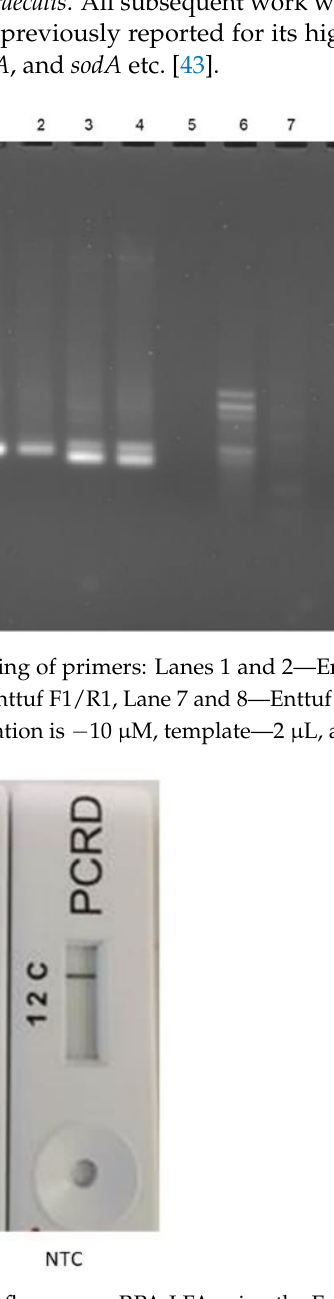
Figure 2. Lateral flow assay: RPA-LFA using the Ent rpoB F1/R1 primer set with positive template E. faecalis DNA (T), and non-template control (NTC).